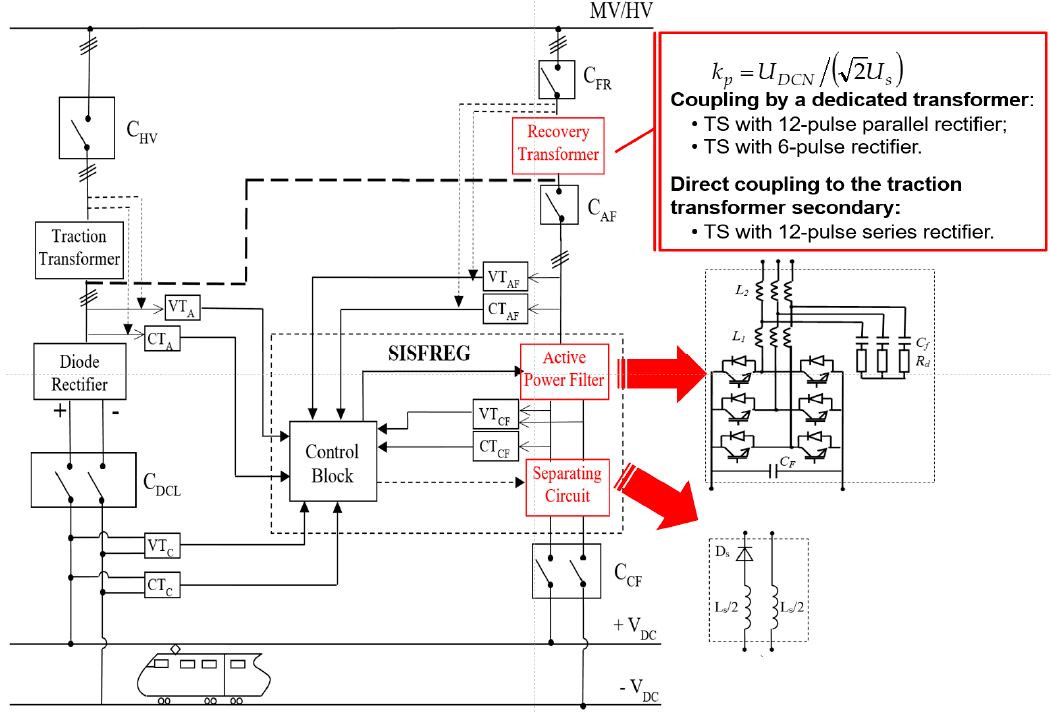
Figure 5. General scheme for connecting SISFREG to an existing DC-traction substation with uncontrolled rectifier [94,103].